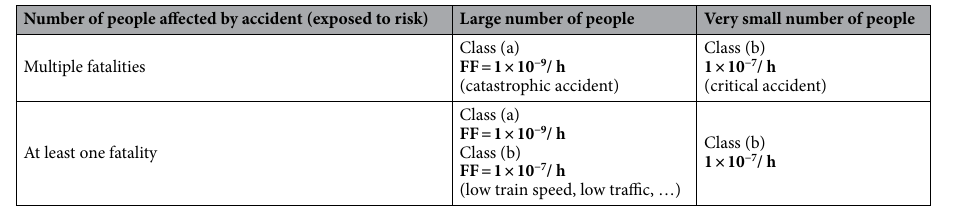
Table 1. Common safety method—design targets for railway technical systems. Significant values are in [bold].